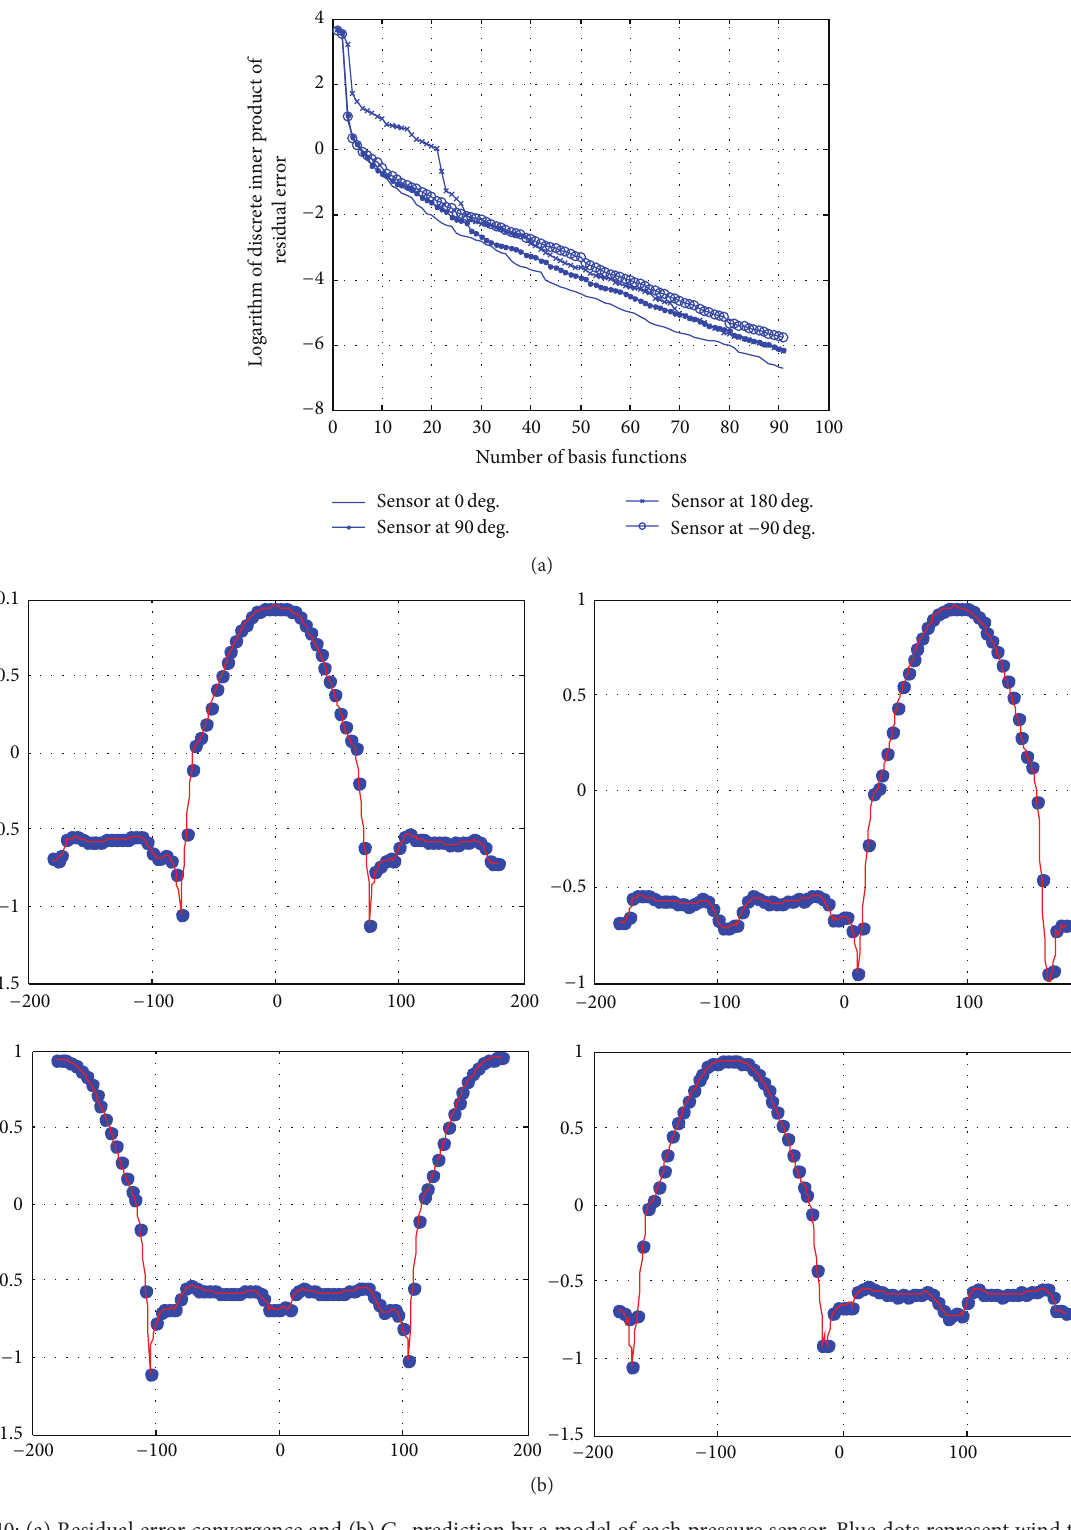
Figure 10: (a) Residual error convergence and (b) 𝐶 𝑝 prediction by a model of each pressure sensor. Blue dots represent wind tunnel data and the red line represents approximation by SFA as a function of the yaw angle. Clockwise from top plots shows 𝐶 𝑝 model of pressure sensor at 0, 90, − 90, and 180